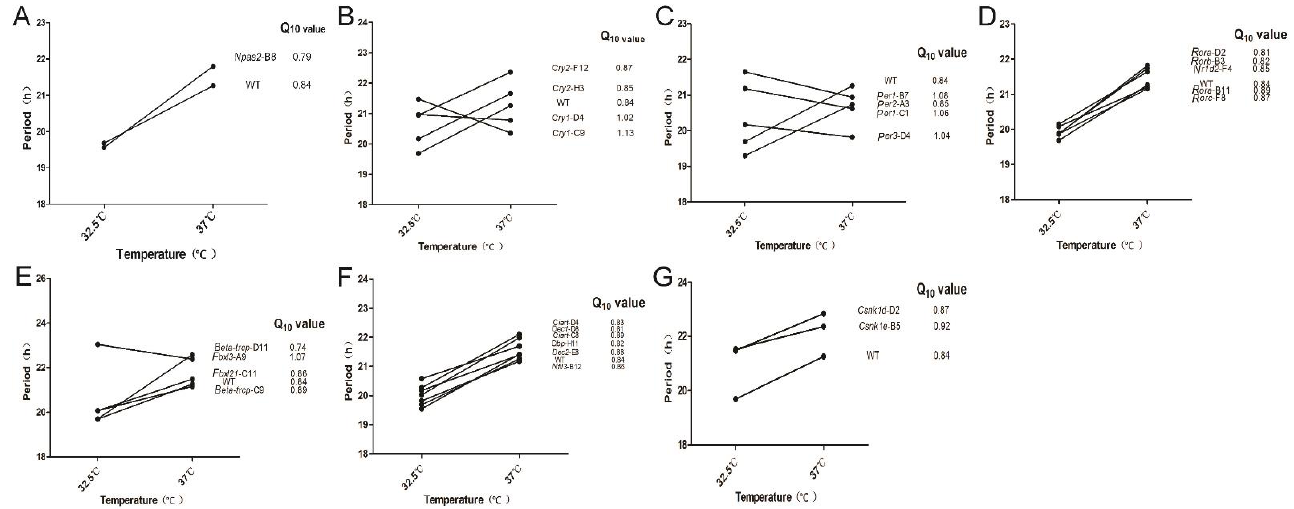
Figure 4. The circadian period changes of monoclonal cell lines at different temperatures. Clock genes in this study were classified into different types. ( A ) The circadian period changes of wild-type and Npas2 -B8 cells at different temperatures. Since Bmal1 deletion and Clock deletion cells were arrhythmic, Npas2 is shown here to represent the core positive regulator group. ( B ) The circadian period changes of Cry1 -D4, Cry1 -C9, Cry2 -F12, Cry2 -H3 cells at different temperatures. ( C ) The circadian period changes of Per1 -B7, Per1 -C1, Per2 -A3, Per3 -D4 cells. Cry and Per genes are core negative regulators. ( D ) The circadian period changes of Rora -B11, Rora -D2, Rorb -B3, Rorc -F8, Nr1d2 -F4 cells, which represent regulators for the Bmal1 gene. ( E ) The circadian period changes of Beta-trcp -C9, Beta-trcp -D11, Fbxl21 -C11, Fbxl3 -A9 cells at different temperatures. These genes represent E3 ligases. ( F ) The circadian period changes of Ciart -C8, Ciart -D4, Dec1 -D8, Dec2 -E8, Dbp -H11, Nfil3 -B12 cells, which represent auxiliary regulators. ( G ) The circadian period changes of the casein kinase genes, Csnk1d -D2, Csnk1e -B5 cells at different temperatures. On the right is their Q 10 value. Periods of each cell line were calculated based on multiple experiments.